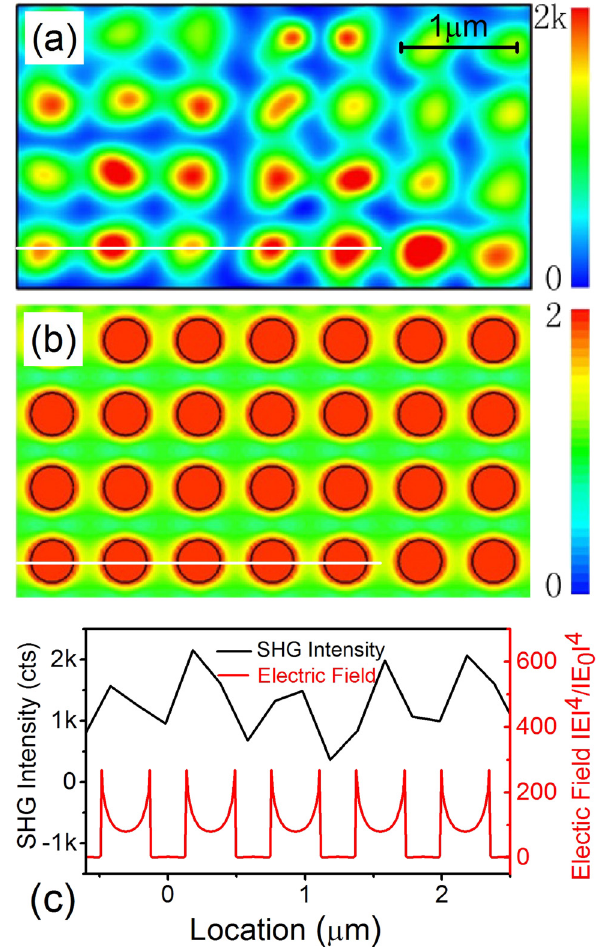
Figure 5: The measured second-harmonic generation (SHG) intensity mapping (a) and calculated total electric field distributions (b) of monolayerMoS 2 onplasmonicstructurewith P =620nm,respectively. (c) The SHG intensity (black line) and electric fi eld intensity (red line) pro fi les along the indicated white line in (a) and